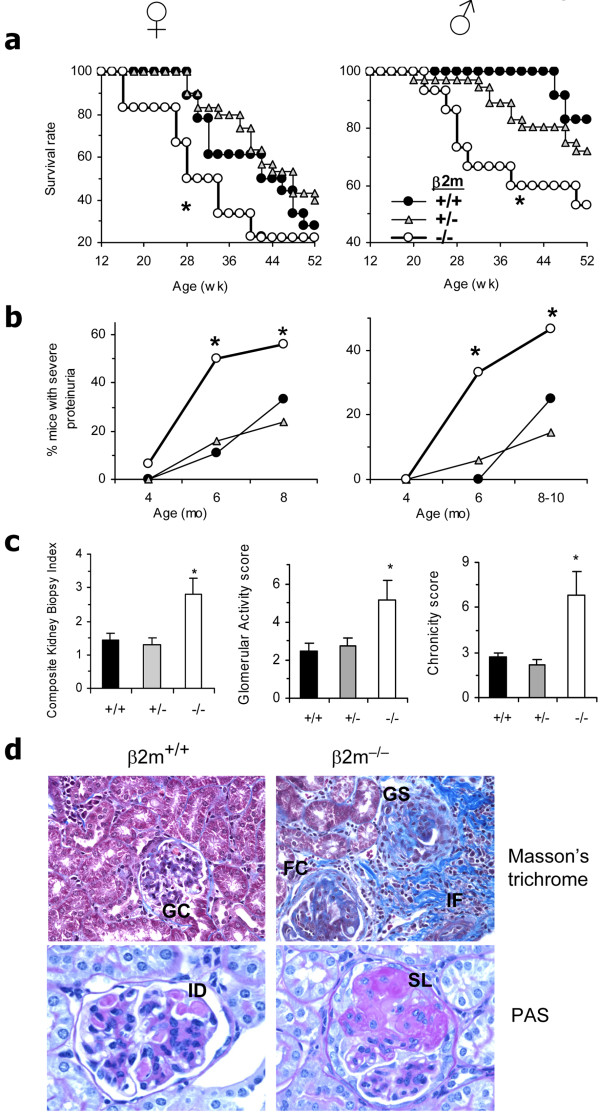
β2 microglobulin (β2m) deficiency reduces survival and accelerates lupus nephritis in BWF1 mice. We monitored 33 β2m-/-(β2m°) (18 female and 15 male, open circles), 66 β2m+/- (30 female and 36 male, triangles) and 31 β2m+/+ (18 female and 13 male, closed circles) littermates for the development of lupus. (a) Cumulative percent survival in β2m° BWF1 mice was compared with control β2m+/- and β2m+/+ littermate mice (*P <0.01 to 0.05, log rank test). (b) Cumulative percent mice with severe proteinuria (≥300 mg/dl protein on two consecutive occasions) was increased in β2m° mice compared to control littermates (*P = 0.02 to 0.05, Fisher's exact test). Differences were more pronounced (P <0.01) when β2m° mice were compared with all controls (β2m+/- plus β2m+/+) mice. (c) Renal histological changes are expressed as the mean ± standard error of the composite kidney biopsy index and its components, glomerular activity and chronicity scores. Results from a representative experiment are shown (*P <0.05, β2m° vs control groups; n = 6 to 8 male 10-month-old mice per group, Student's t-test). (d) Representative kidney sections from these mice show severe kidney lesions with fibrosis (note increased aniline blue staining) in the glomeruli (glomerulosclerosis, GS), periglomerular region (fibrous crescent, FC) and interstitium (IF), interstitial inflammation, and large segmental lesions (SL) in β2m° mice, whereas the β2m+ mice showed relatively less advanced lesions with increased glomerular cellularity (GC) and typical immune deposits (ID, see pink-colored deposits), but minimal or no GS or IF. PAS, periodic acid Schiff.